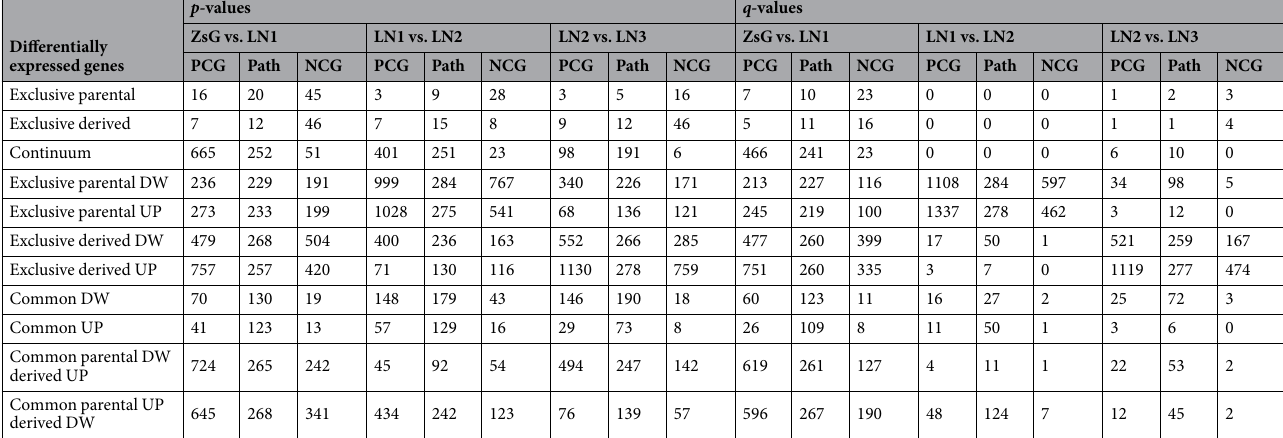
Table 1. Number of protein coding genes (PCG), KEGG pathways (Path) and non-coding genes (NCG) differentially expressed for each cluster of gene expression between parent-derived cell lines of tongue metastatic progression, for p- and q- values.